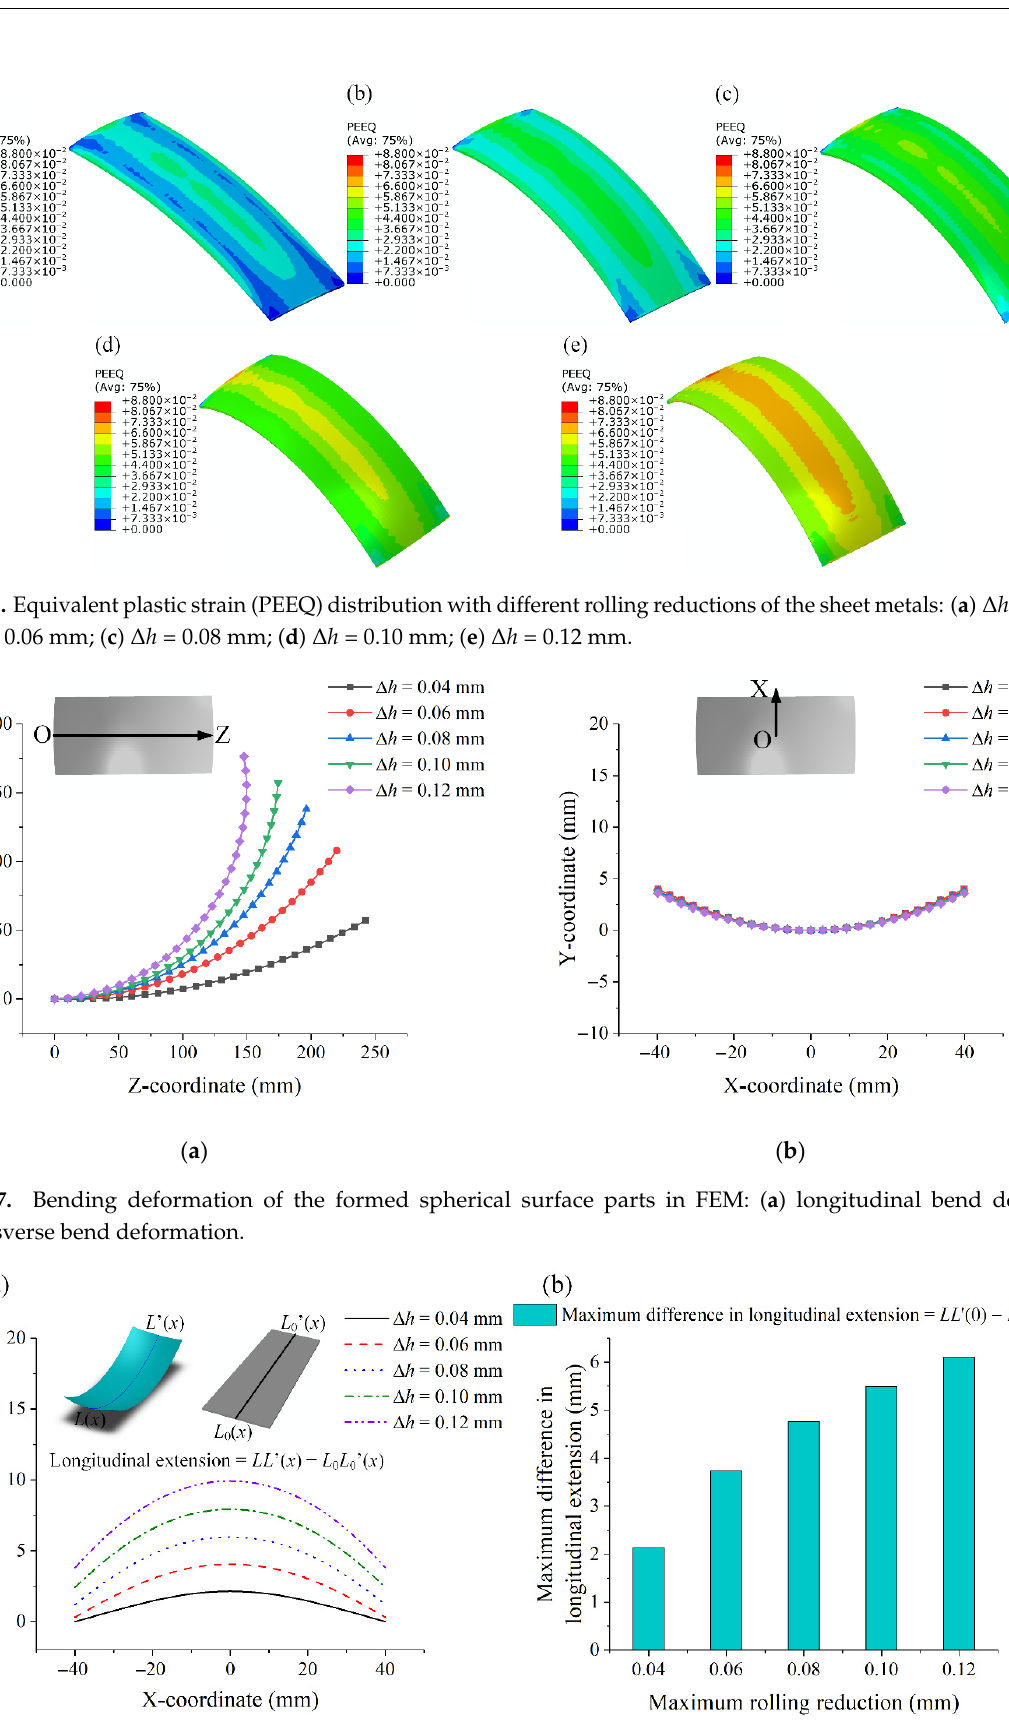
Figure 8. Longitudinal extension of formed spherical parts with different rolling reductions: ( a ) longitudinal extension of different positions in the transverse direction; ( b ) maximum difference in longitudinal extension.